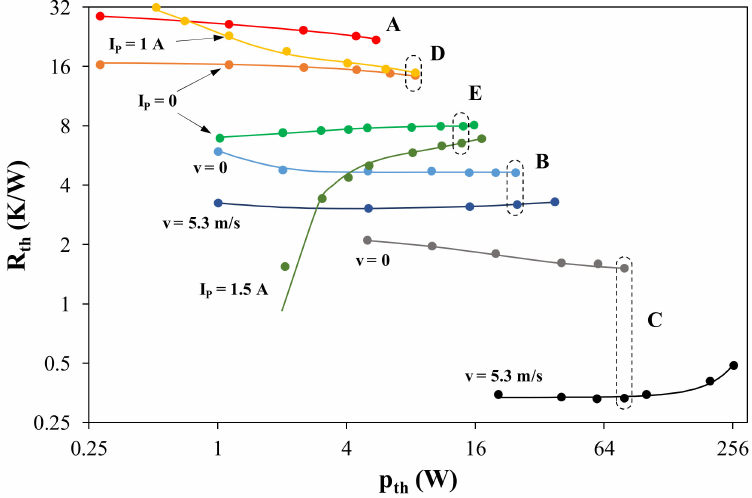
Figure 21. Measured and computed dependences of the thermal resistance of the resistor on the dissipated power in all the investigated cooling